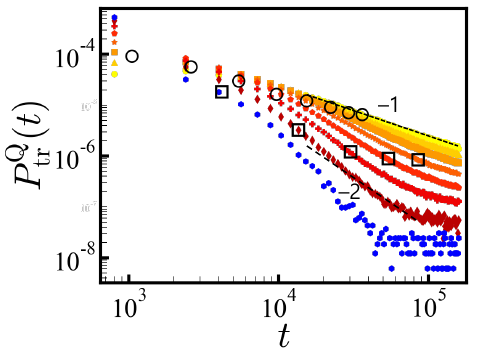
Figure 3. Distributions of translocation times (in the reverse direction) for various Q -ensembles of N = 20. The PDF measures the fraction of translocated sequences at given time interval [ t − δ t /2, t + δ t /2] with δ t = 1600 MCT for each Q -ensemble. Each distribution is normalized by the total number of successfully translocated sequences with t w = 1.6 × 10 5 MCT. Colors from yellow to blue represent charge values of Q = 0, 2, 4, 6, 8, 10, 12 and 14, respectively. The dashed lines are a guide for the eyes indicating power-law relations, P ( t ) ∼ t − ( 1 + µ ) with µ = 0 and 1. For each Q , we indicate the average translocation times (cid:104) t tr (cid:105) by ◦ . The (cid:104) t tr ( Q ) (cid:105) decreases with increasing net charges. The square symbols for Q = 6, 8, 10, 12 and 14 represent the average translocation times (cid:104) t tr ( Q ) (cid:105) with t w = 10 6 MCT.